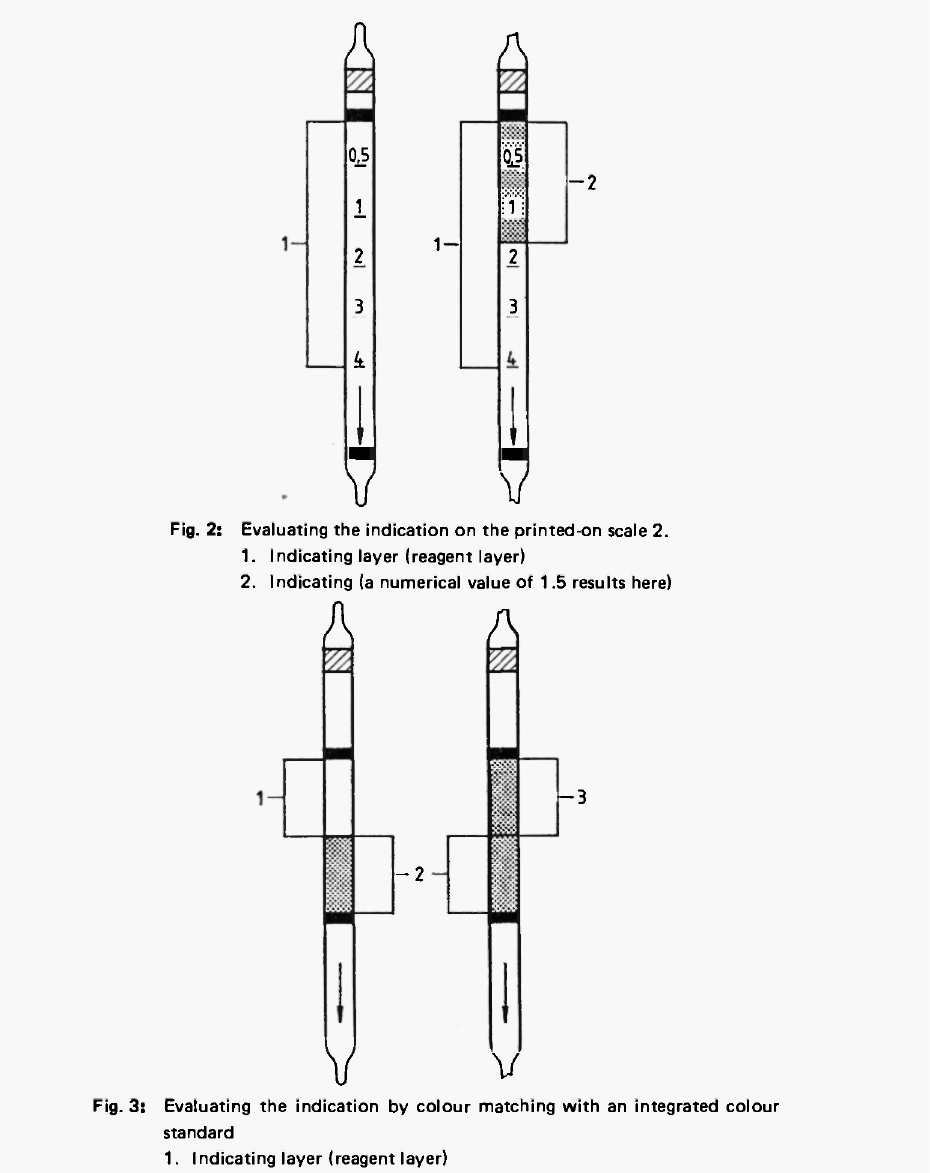
Fig. 3: Evaluating the indication by colour matching with an integrated colour